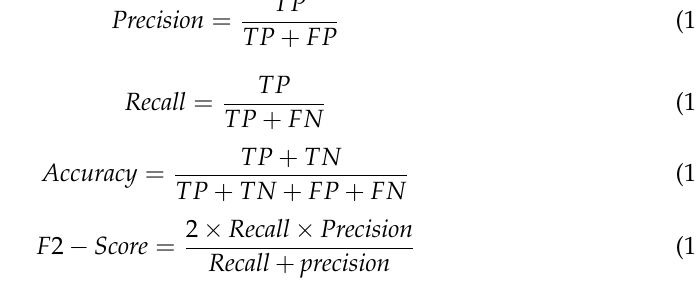
Table 6. Classification report of our model with augmentation learning. Our Model with Augmentation Learning Predicted Crystal